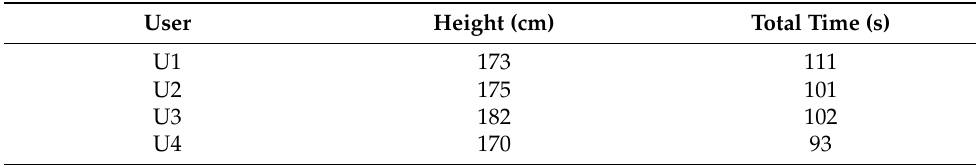
Table 6. User ID, height, and total time for performing the actions described in Table 5. The total time is computed cumulating the crossing time at the base of the cone corresponding to the angular aperture of the sensor (Figure